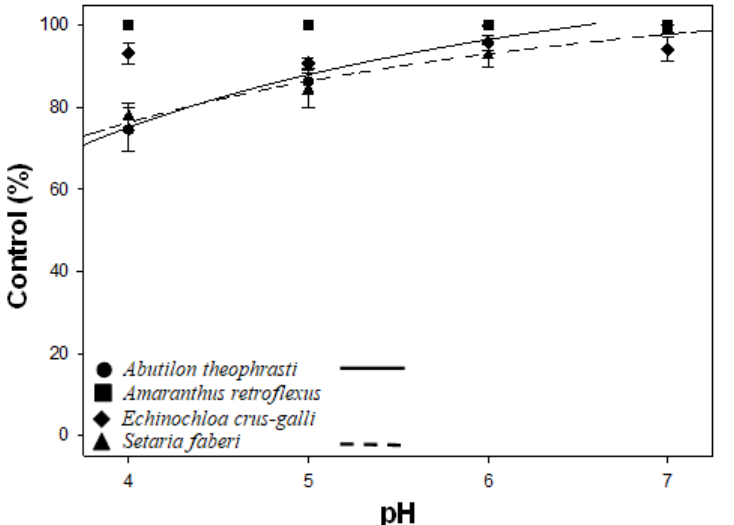
Figure 3. Control of flumioxazin on select weed species as affected by soil pH. Fitted lines are calculated by the inverse first-order regression equation ( y = b + a/x ) for Abutilon theophrasti and Setaria faberi ( p < 0.05). Flumioxazin control on A. theophrasti and S. faberi increased with increasing soil pH. Flumioxazin control on Amaranth retroflexus and Echinochloa crus-galli did not change across soil pH ( p > 0.05). The vertical bars represent the standard error of means.